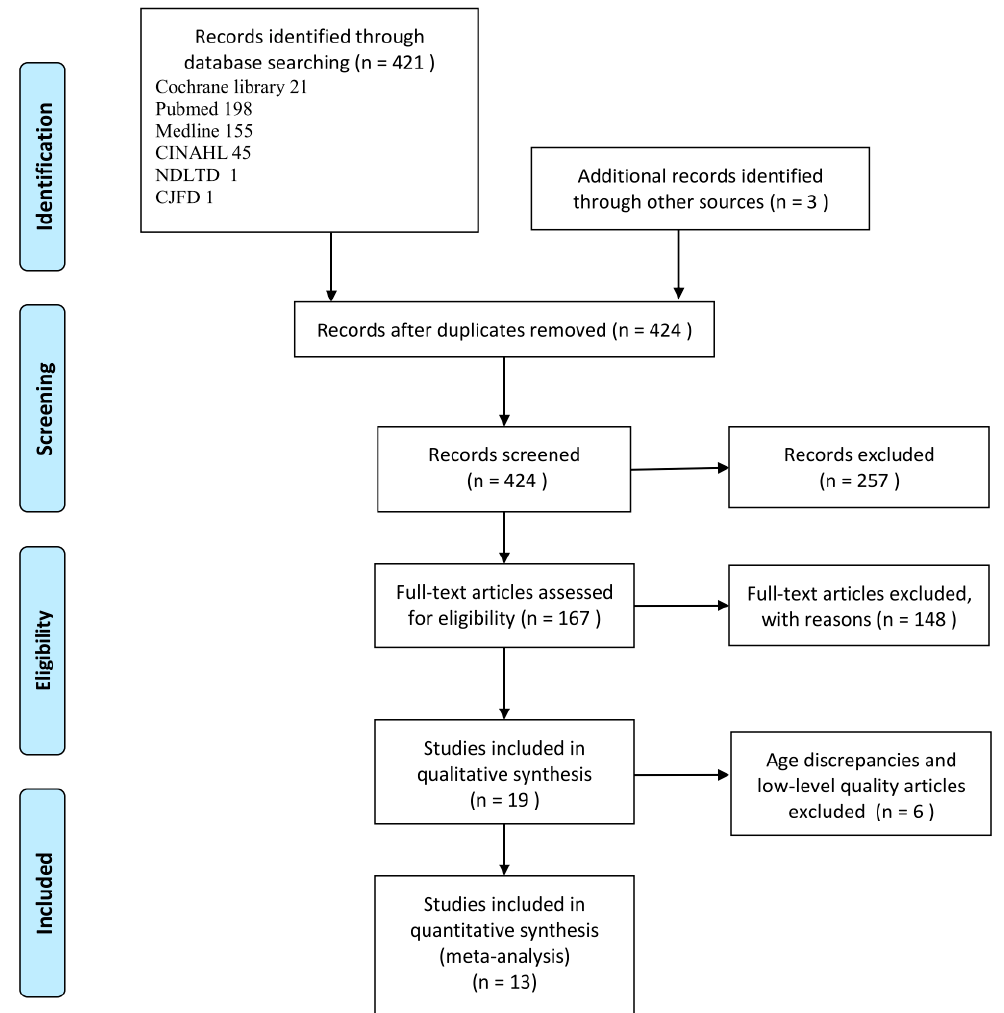
Figure 1. Flow chart of the literature search and study selection.